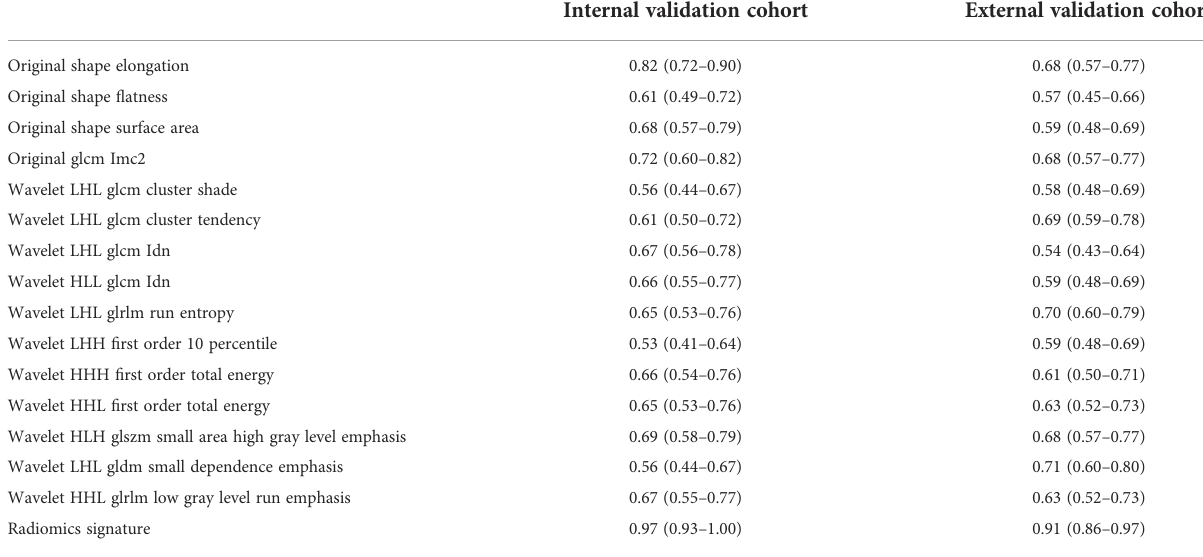
TABLE 3 The performance of selected radiomic features to predict MMR